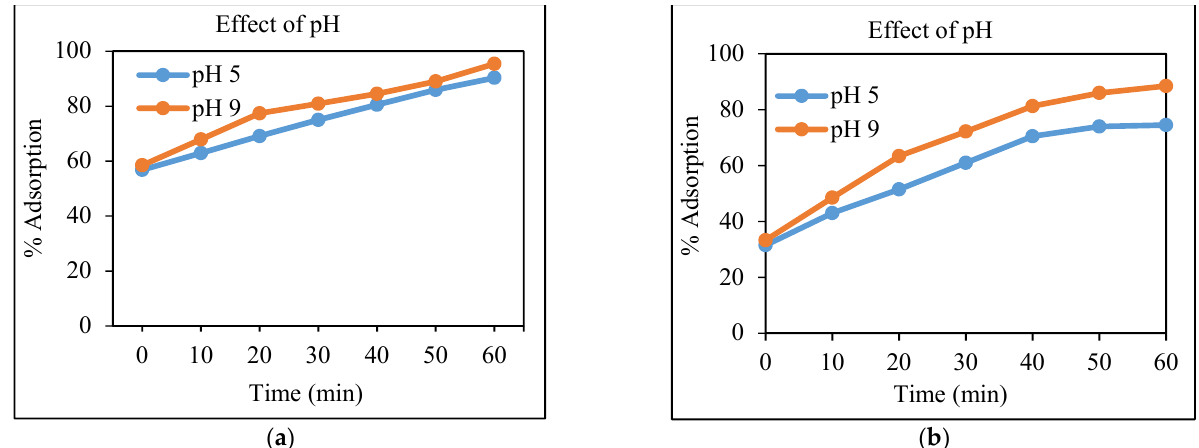
Figure 5. Removal (in percentage) of Cd ( a ) and Cr ( b ) using the CeO 2 /corncob nanocomposite as a function of pH (at an optimum dose and concentration).